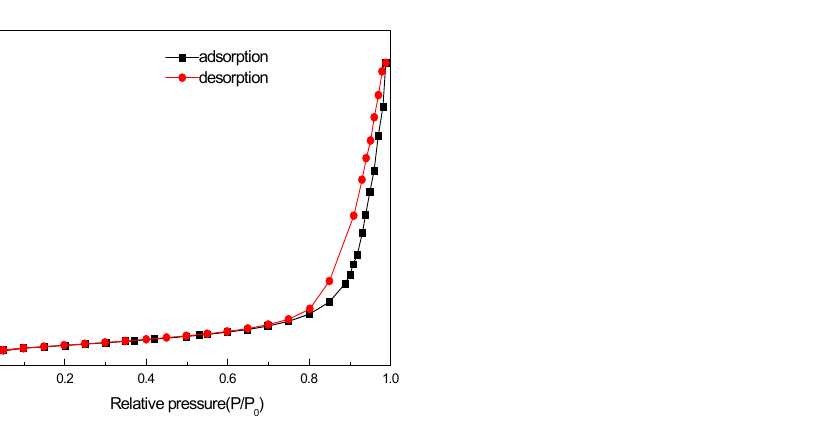
Figure 5. STEM ( a ) and particle size distribution histogram ( b ) of Pd-Ni/ γ Al 2 O 3 -SiO 2 catalyst . 2.2.3. XPS